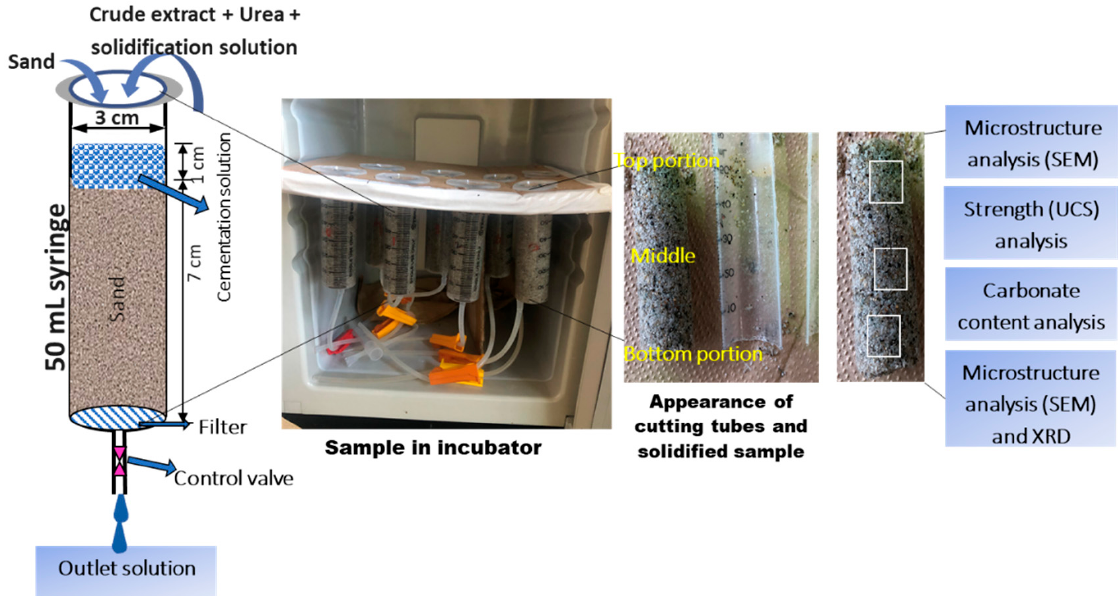
Figure 3. Experimental protocol used in this study (UCS—unconfined compressive strength). Table 3. Testing conditions for sand solidification.